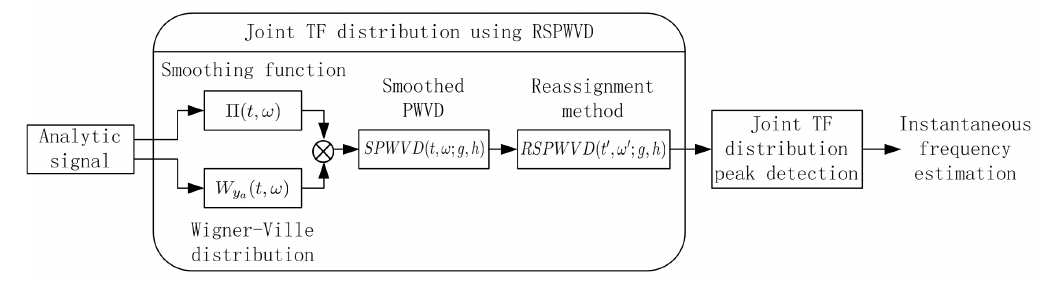
Joint TF distribution based on reassigned smoothed pseudo Wigner–Ville distribution (RSPWVD) in interference detection for GNSS